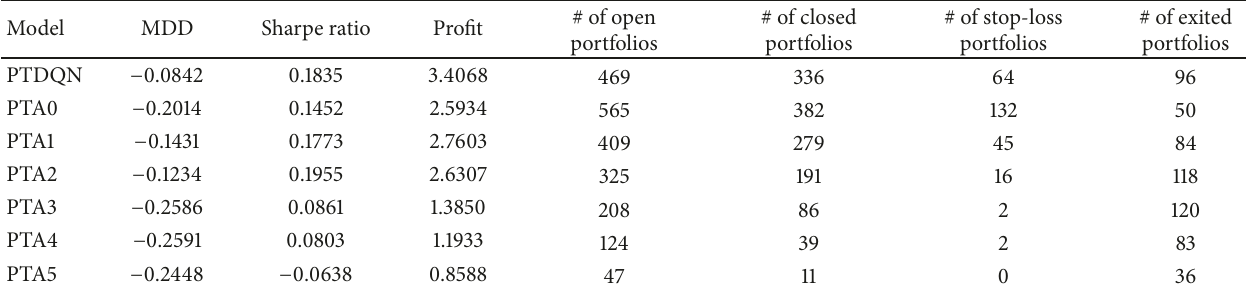
Table 6: Average top-5 performance results for XOM and CVX using OLS within the training period.